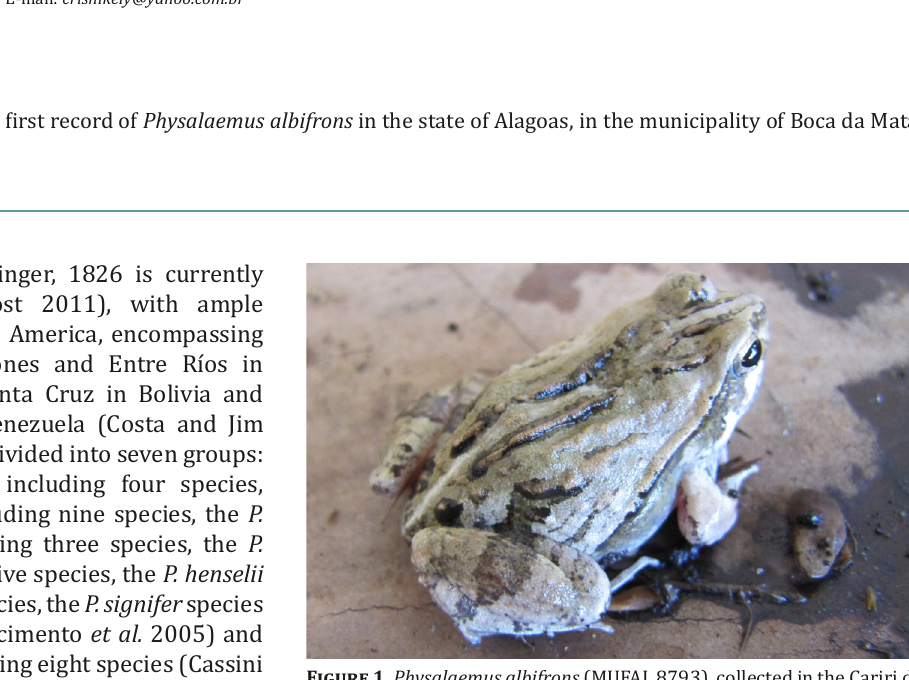
Physalaemus albifrons